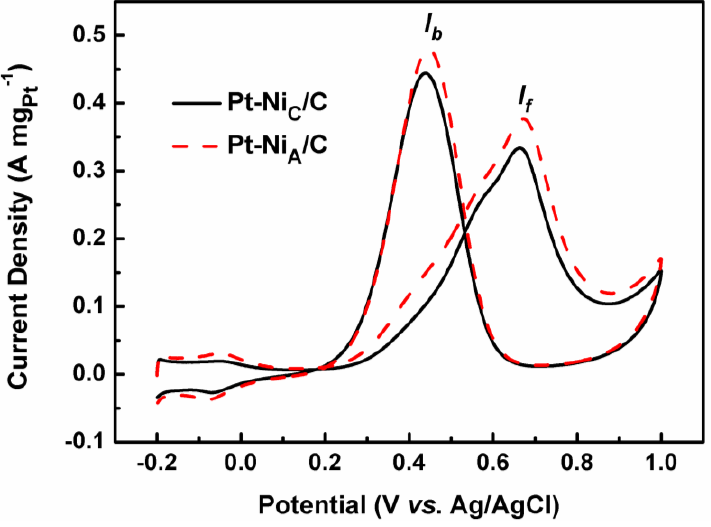
Figure 6. Cyclic voltammograms of the Pt-Ni H SO + 0.5 mol L −1 CH 2 4 of 50 mV s −1 .